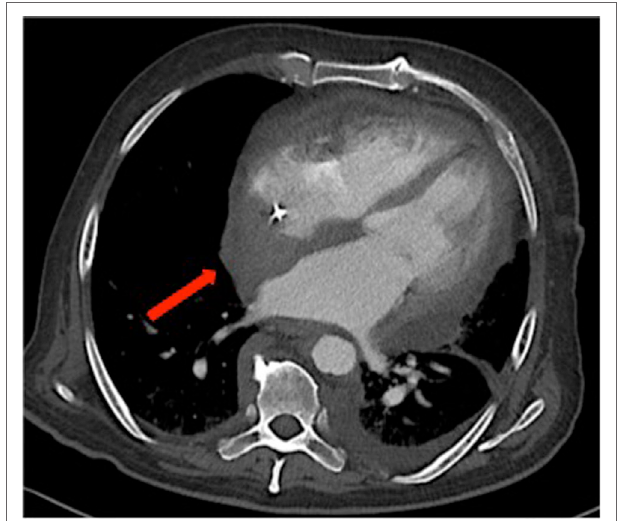
FIGURe 1 | A contrast-enhanced computed tomography showing thickening of the pericardial sheets, pericardial effusion and a pseudo-tumoral infiltration of the right atrium [ red arrow